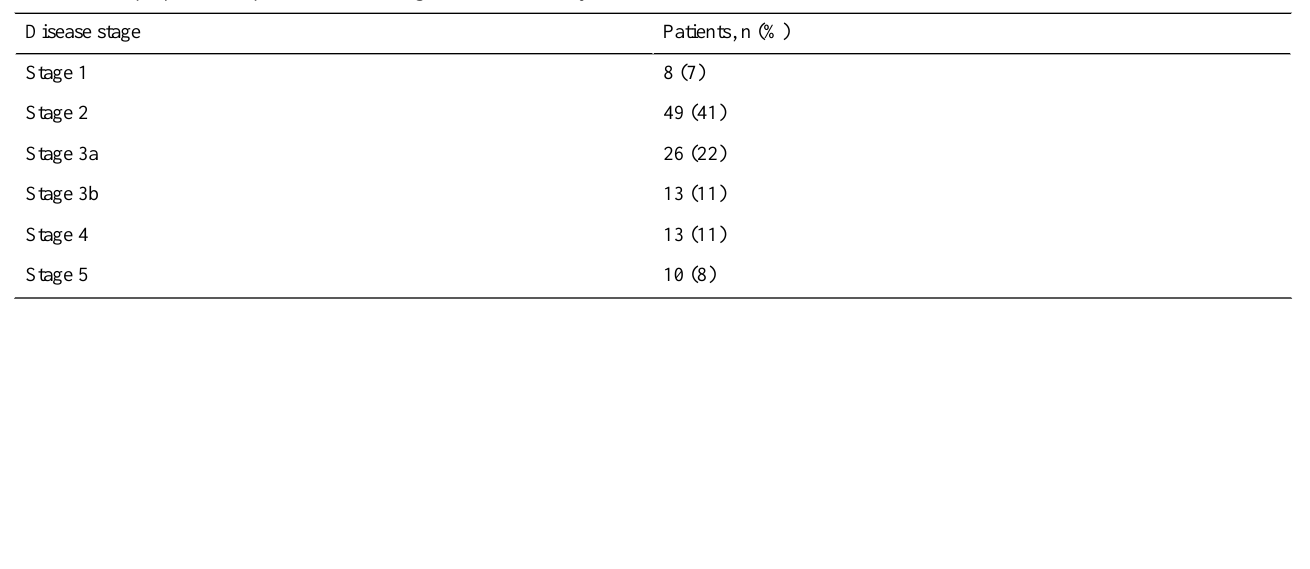
Table 2. The proportion of patients in each stage of chronic kidney disease